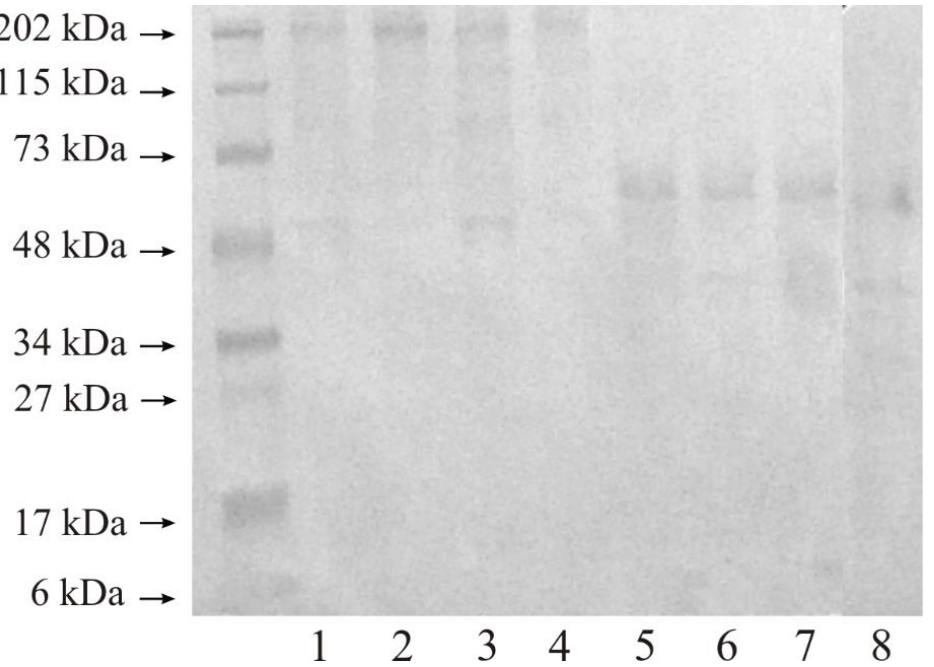
Figure 4. Western immunoblot of MMP-3 in respective control tissue and G2 grade and G3 grade human kidney tumor. Twenty micrograms of protein were applied to the gel. Separation in non-reducing conditions: Lane 1—control kidney for G2 grade tumor, 2—G2 grade of kidney tumor, 3—control kidney for G3 grade tumor, 4—G3 grade of kidney tumor. Separation in reducing conditions: Lane 5—control kidney for G2 grade tumor, 6—G2 grade of kidney tumor, 7—control kidney for G3 grade tumor, 8—G3 grade of kidney tumor.